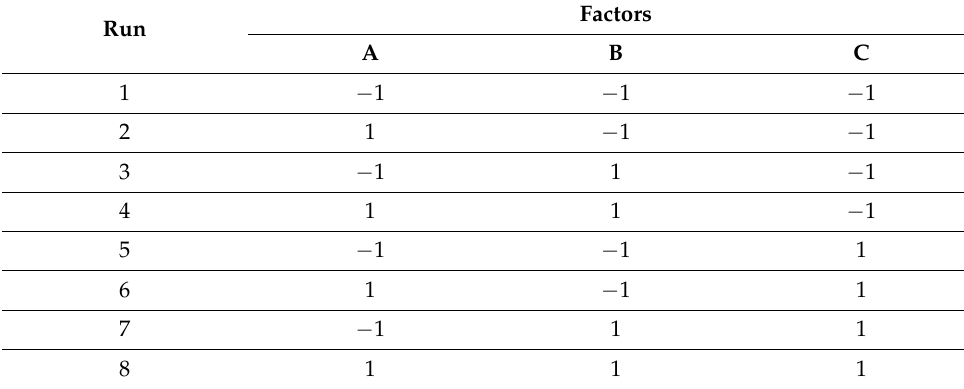
Table 1. Example of a 2 (cid:2871) factorial design matrix.